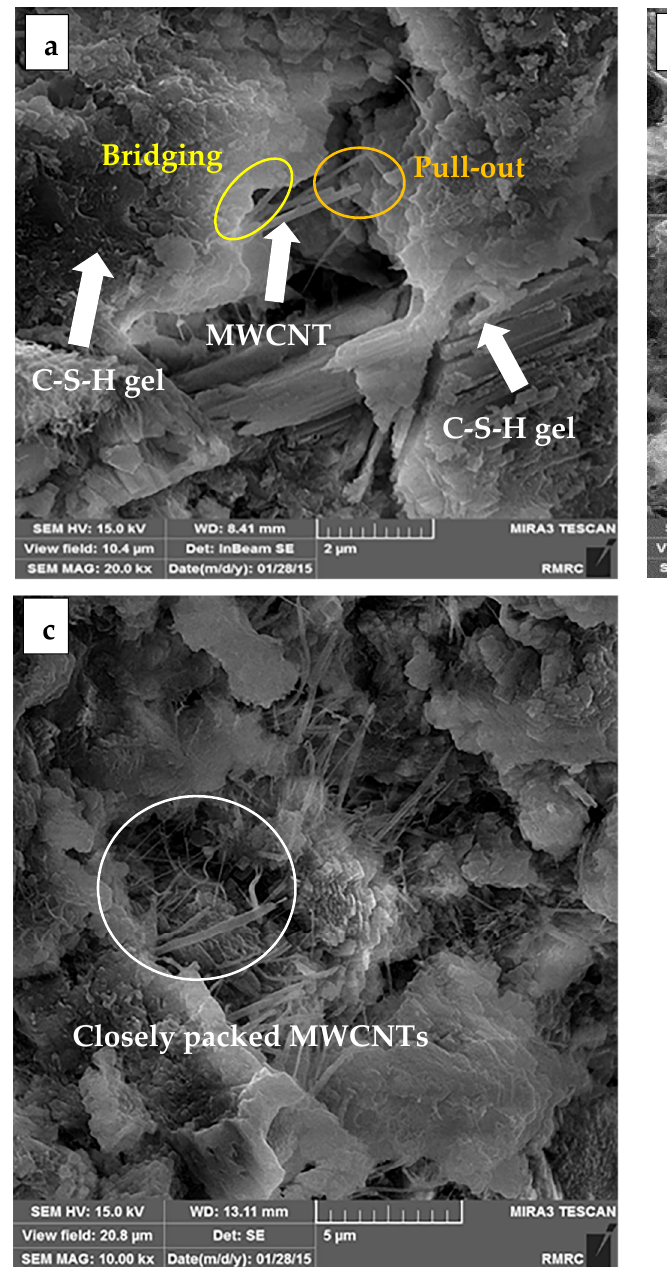
Figure 5. SEM images of the cement paste with w/c of 0.3: ( a ) bridging and pull out response of the MWCNT in for the SiO 2 0.5–CNT 0.06 specimen; ( b ) carbon nanotube’s distribution in the prepared SiO 2 0.5–CNT 0.06 specimen; and ( c ) Ca(OH) 2 crystals developed from hydration in the SiO 2 2.0–CNT 0.3 specimen.